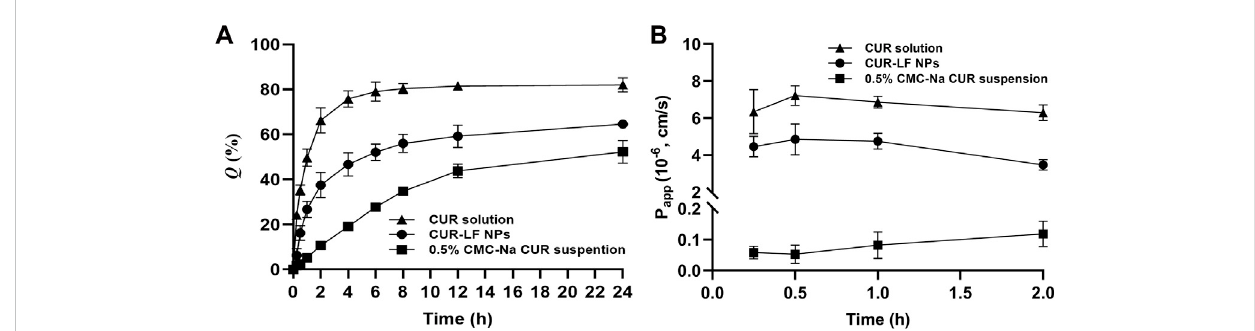
FIGURE 3 In vitro delivery evaluation (A) In vitro release of curcumin solution, 0.5% carboxymethyl cellulose sodium (CMC-Na) curcumin suspension, and CUR-LFNPs (B) Theapparentpermeabilitycoef fi cientofcurcuminsolution,0.5%CMC-Nacurcuminsuspension,andCUR-LFNPsonMDCKmonolayer. Data were presented as mean ± SD ( n =